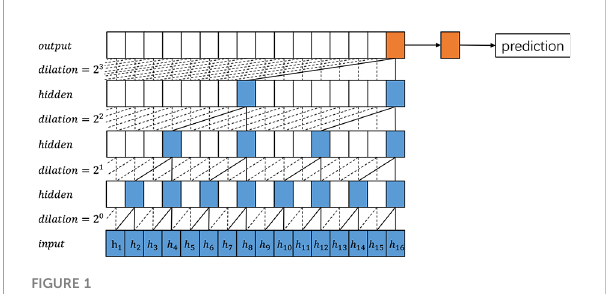
FIGURE 1 An overview of the proposed TCN